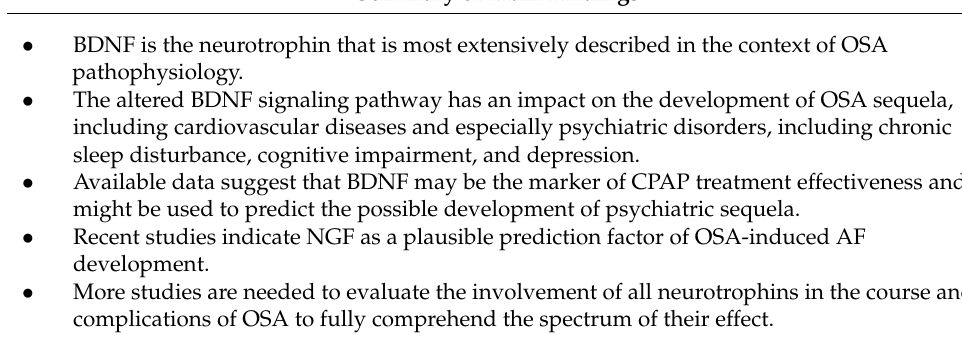
Table 1. Summary of the main findings from the review. Summary of Main